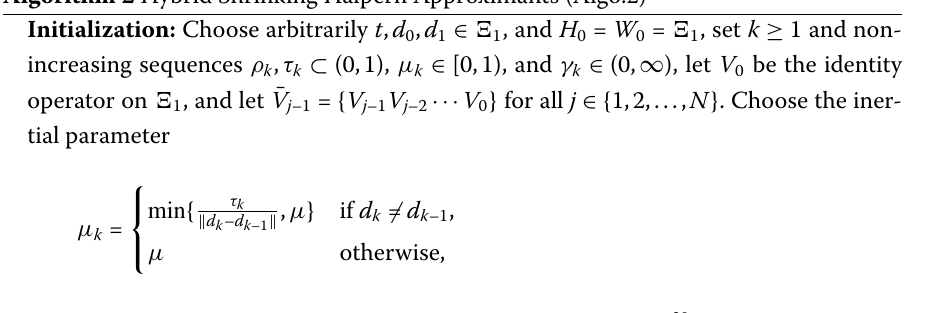
Algorithm 2 Hybrid Shrinking Halpern Approximants